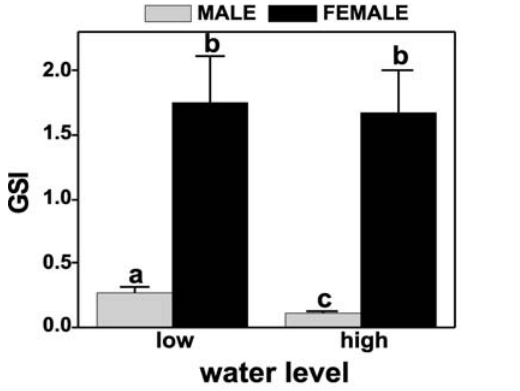
Fig. 4. Means and standard errors (vertical lines) for gonadosomatic index (GSI) by sex and water level periods for Geophagus brasiliensis in the Lajes Reservoir. Distinct letters (a, b, c) indicate significant differences at 95% level of